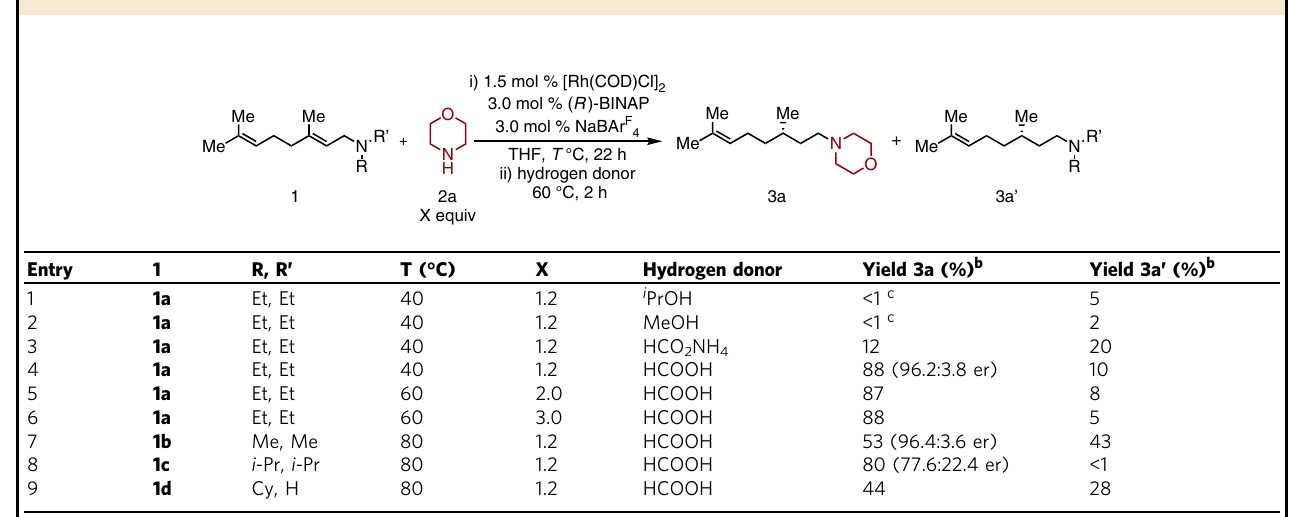
Table 1 Selected optimization of reductive amination of allylic amines